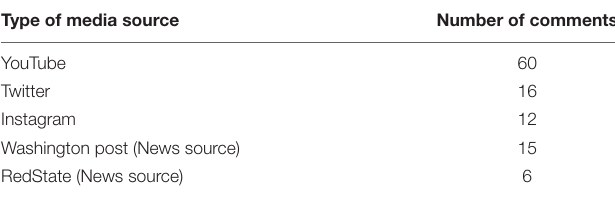
TABLE 1 | Media source and number of